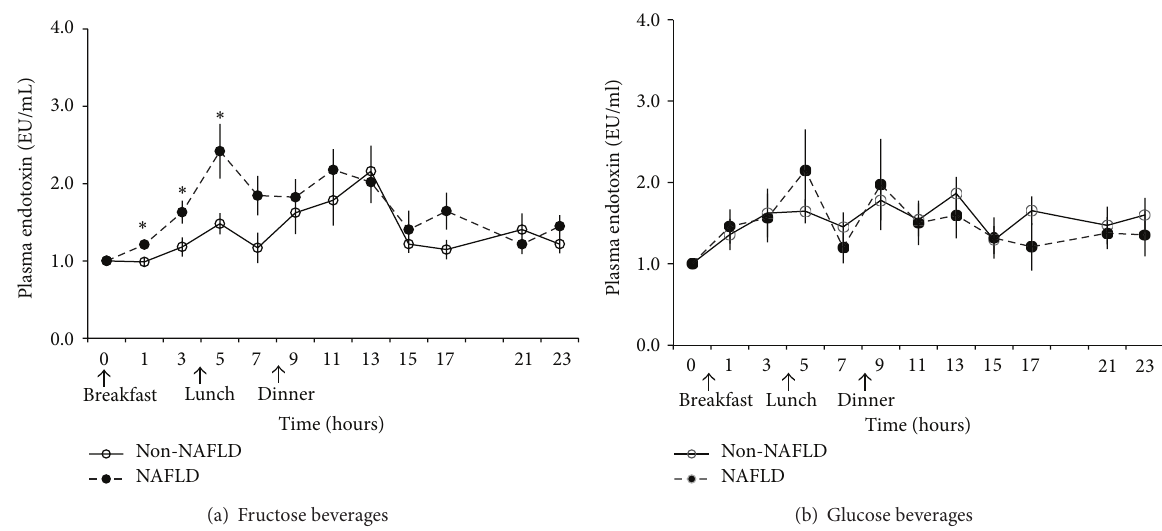
Figure 2: Postprandial plasma endotoxin levels in response to (a) fructose and (b) glucose beverages given with breakfast, lunch, and dinner. The solid line represents 7 children without NAFLD and the dashed line shows the response in 8 children with biopsy-proven NAFLD. Baseline values were set as reference (1.0) and the following time points represent the ratio to baseline. ∗ 𝑃 < 0.05 when comparing NAFLD and non-NAFLD subjects at given time